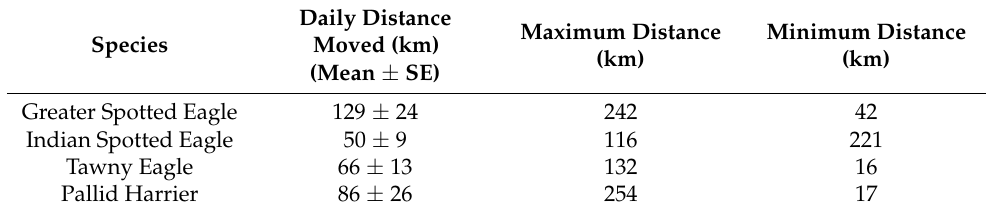
Table 4. Daily average distance travelled during migration and non-migration months by four raptor species. The daily distance indices presented here were estimated using Tracking Analyst Tools in ArcGIS 10.8.1. Minimum and maximum distances correspond to the days during which raptors were non-migratory and the maximum distance corresponds to the days of active migration.